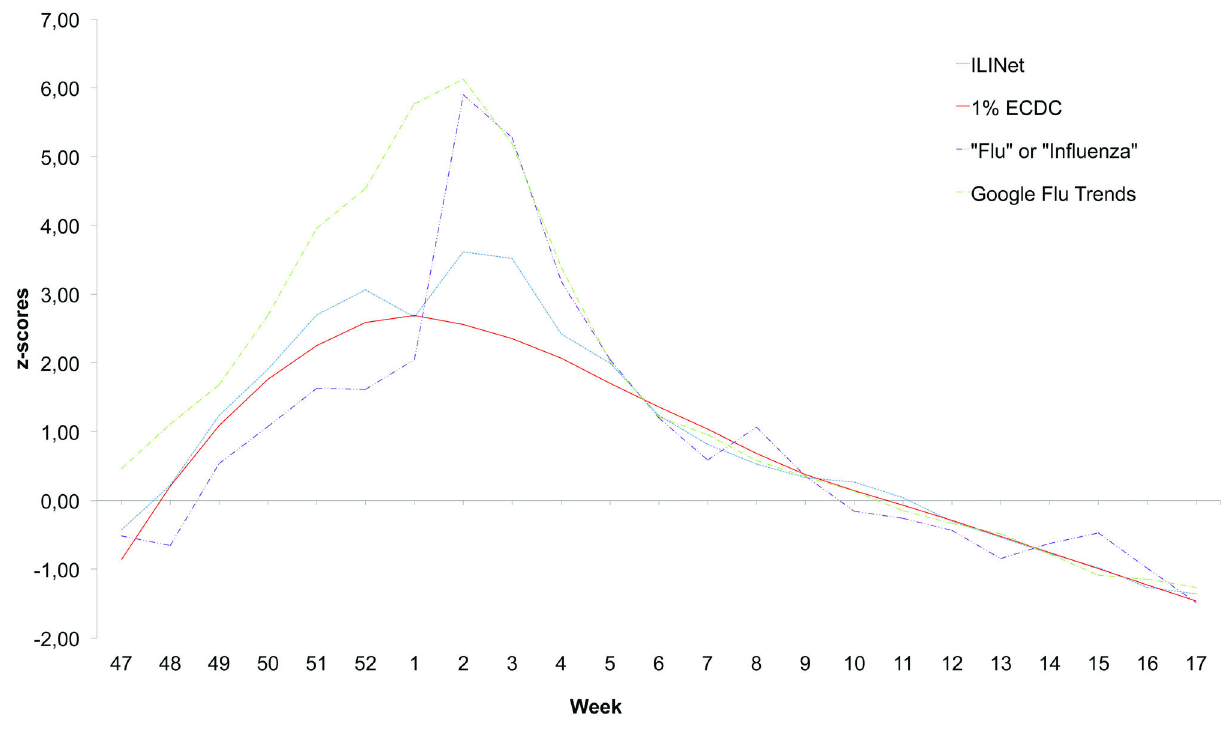
Figure 1. Weekly reported ILI (CDC) and tweets satisfying ILI query. The blue line represents the z-scores of CDC’s reported ILI for the 23-week period starting in week 47 (November 2012) through week 17 (May 2013). The red line represents the z-scores of tweets satisfying the ECDC ILI query. The purple line represents the z-scores of tweets including the words “flu” or “influenza”. The green line represents the z-scores of Google Flu Trends